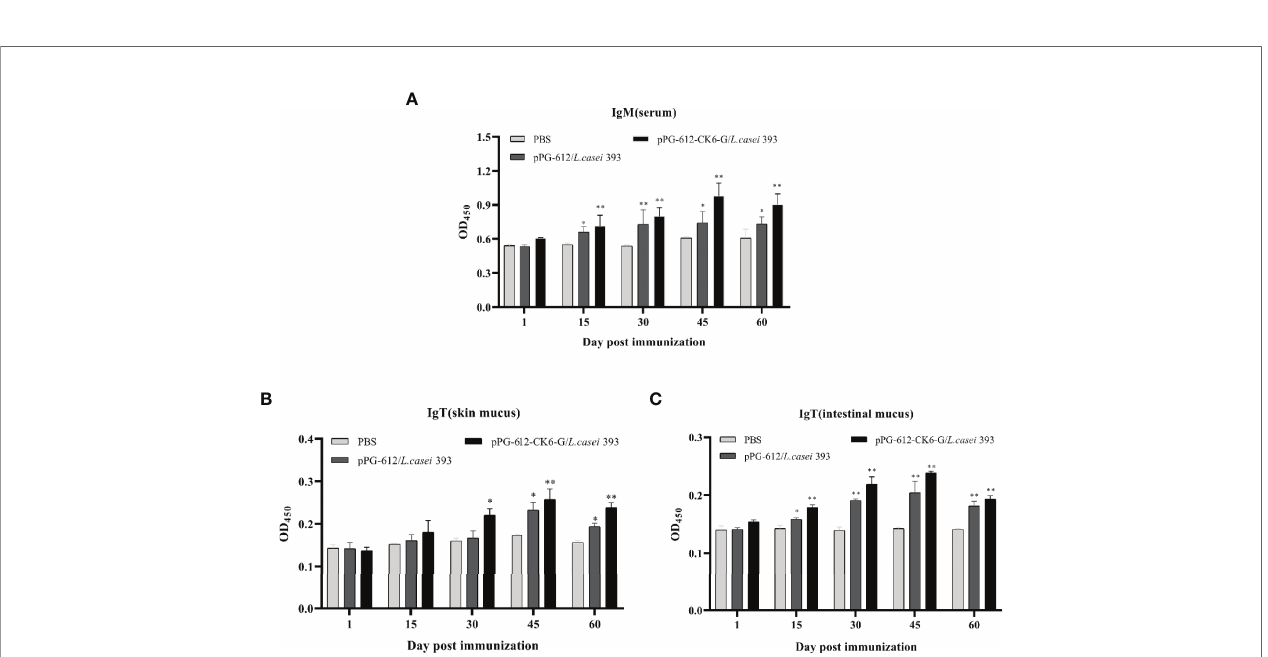
FIGURE 3 | Levels of speci fi c antibody expression in different tissues 60 days after secondary immunization. (A) Changes in IgM levels in serum at different time periods; (B) changes in IgT levels in skin mucosa at different time periods; (C) changes in IgT levels in intestinal mucosa at different time periods. Data are presented as mean ± SD and P values were calculated using one-way ANOVA and LSD post hoc tests. * represents p <0.05, ** represents p